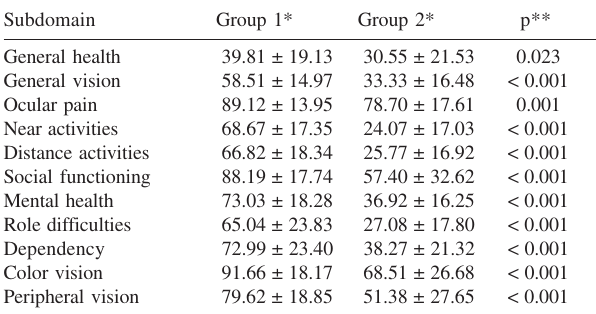
Table 3 - Comparison of the NEI VFQ – 25 subdomain scores based on the responses of patients with age-related macular degeneration and monocular (group 1) legal blindness and the control group at the University of